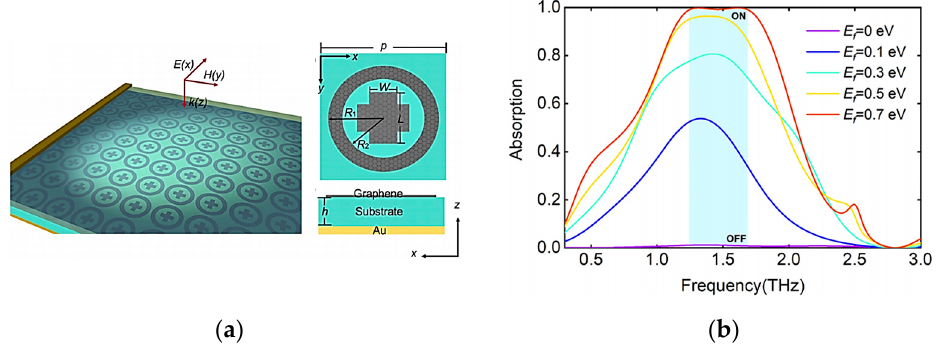
Figure 26. ( a ) The structure of the polarization-insensitive broadband metamaterial absorber based on graphene and ( b ) the broadband absorption curve with EF [64]. on graphene and ( b ) the broadband absorption curve with EF